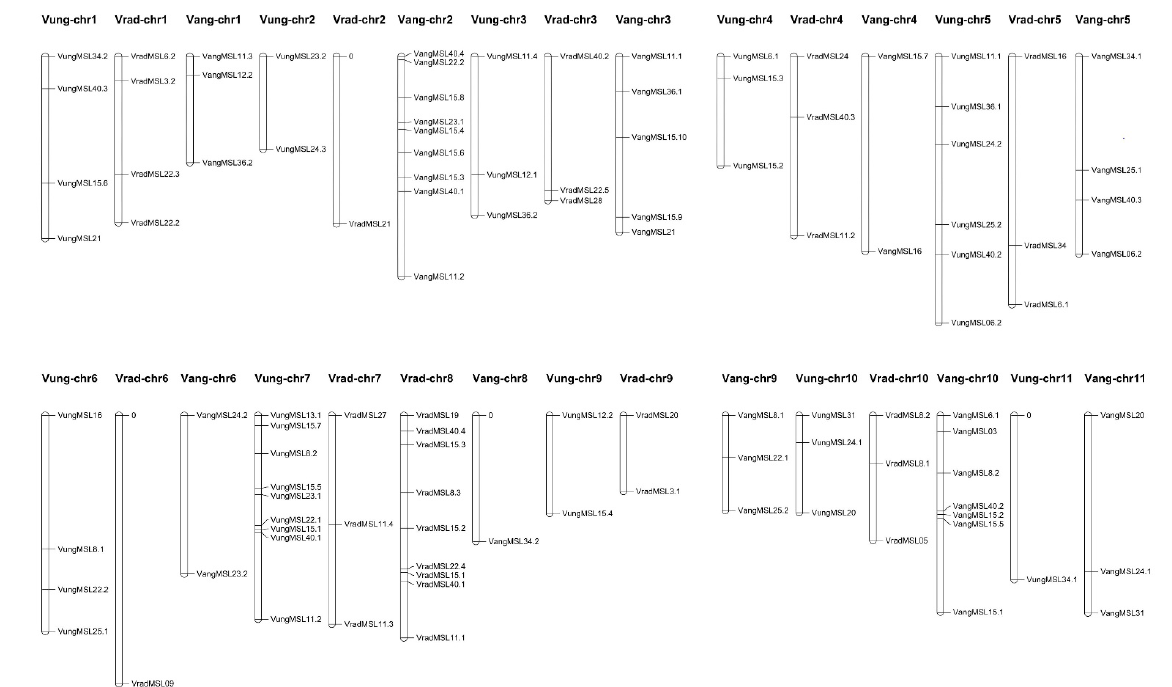
Figure 5. Chromosomal locations of trihelix genes of cowpea, mung bean and adzuki bean. Chromosome number is mentioned at the top. The chromosomes are presented in the order— cowpea (Vung, V. unguiculata ), mung bean (Vrad, V. radiata ) and then adzuki bean (Vang, V. angularis ).